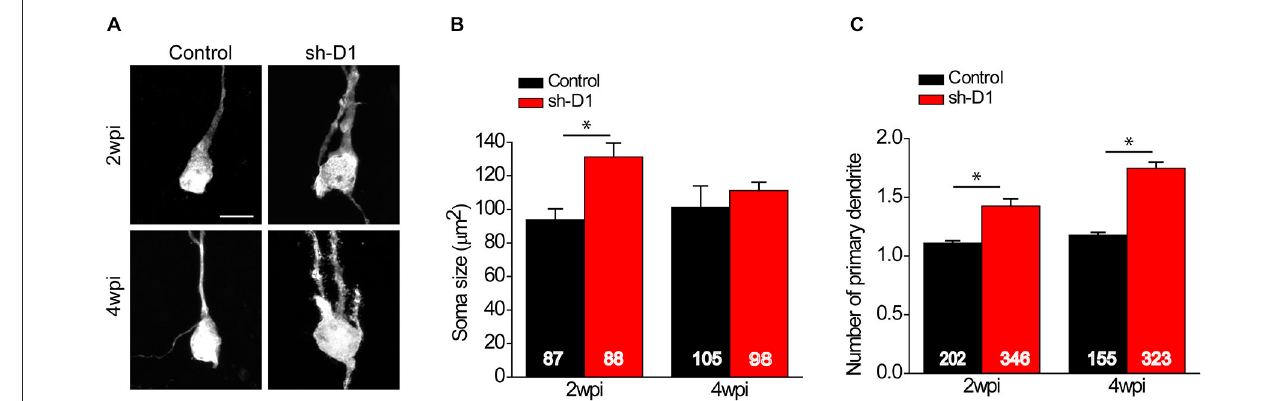
neurons analyzed from 3–8 animals under each condition. Values represent mean ± SEM (* p < 0.05; Two- way ANOVA; 2 wpi: control, n = 87, sh-D1, n = 88; 4 wpi: control 105, sh-D1, n = 98). (C) Quantification of number of primary dendrites of GFP + neurons at 2 and 4 wpi. Numbers indicated in each bar graph represent the total number of neurons analyzed from 3–8 animals under each condition. Values represent mean ± SEM (* p < 0.05; Two-way ANOVA; 2 wpi: control, n = 202, sh-D1, n = 346; 4 wpi: control, n = 155, sh-D1, n =